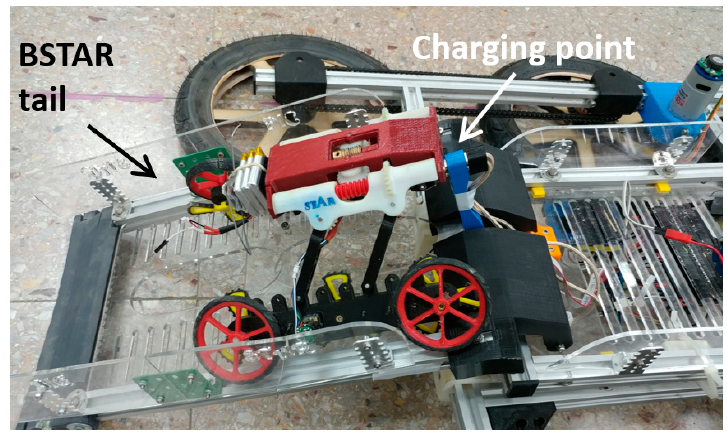
Figure 20. The RSTAR connecting to the charging point of the BSTAR (see video in Supplementary